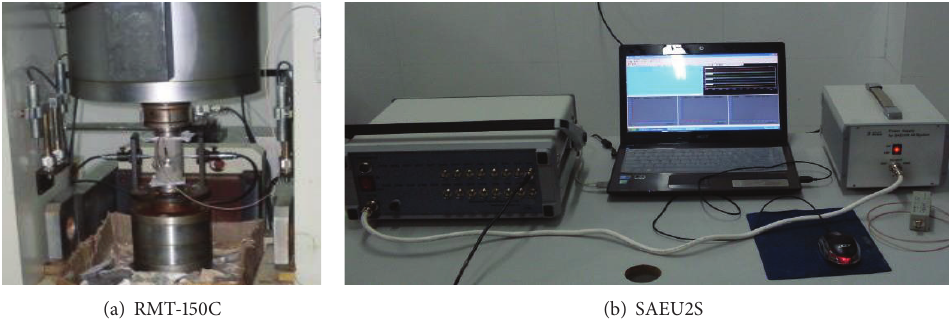
Figure 1: The servo controlled rock mechanical test machine RMT-150C and AE monitoring system